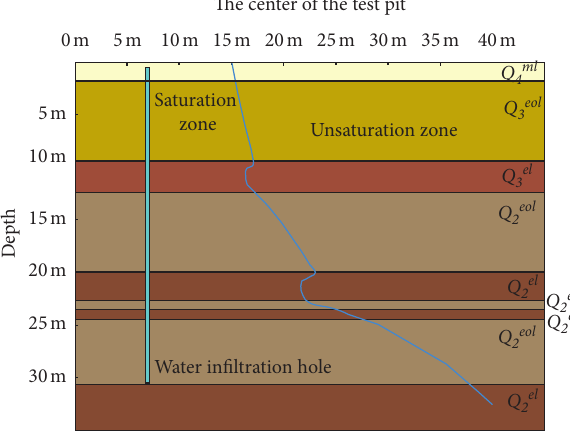
Figure 7: The scopes of the immersion area and saturated area of immersion